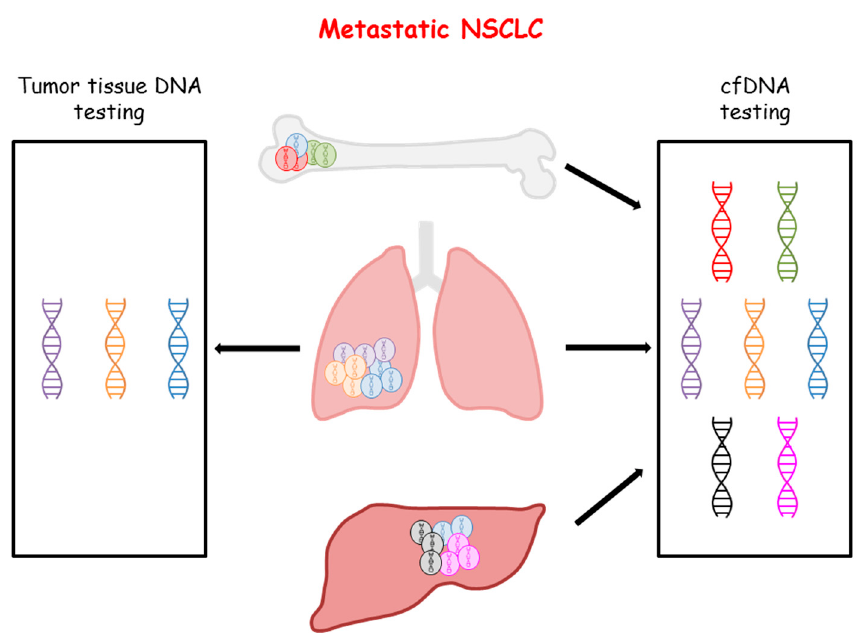
Figure 1. Representation of tumor heterogeneity detected with tumor tissue and cfDNA testing for metastatic NSCLC patients.